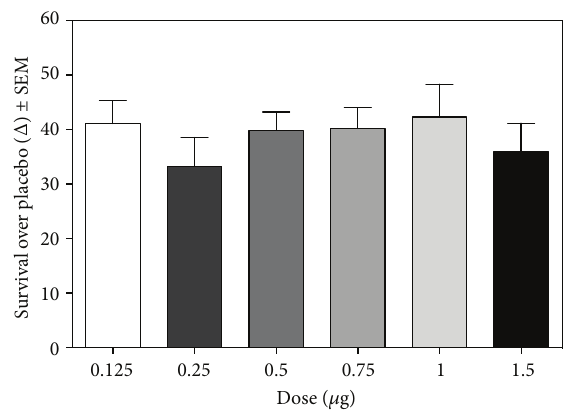
Figure 3: Evaluation of biological activity of 27 Transferon batches in the validated murine model of herpes. Statistical analysis (ANOVA, Bonferroni’s Multiple Comparison Test) showed no differences between